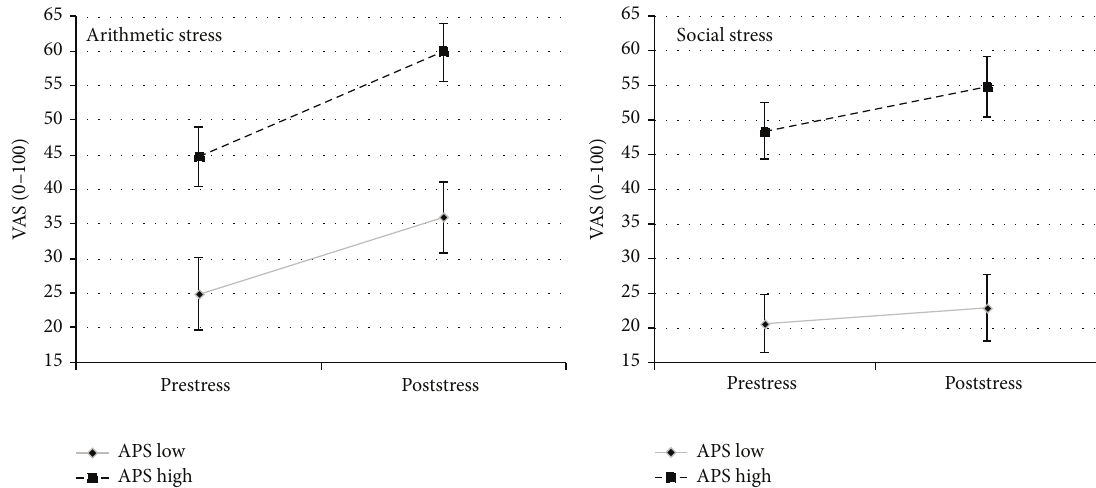
Figure 3: Repeated-measures ANOVA for stress-response in low versus high APS groups. APS: Arousal Predisposition Scale; VAS: visual analogue stress scales.